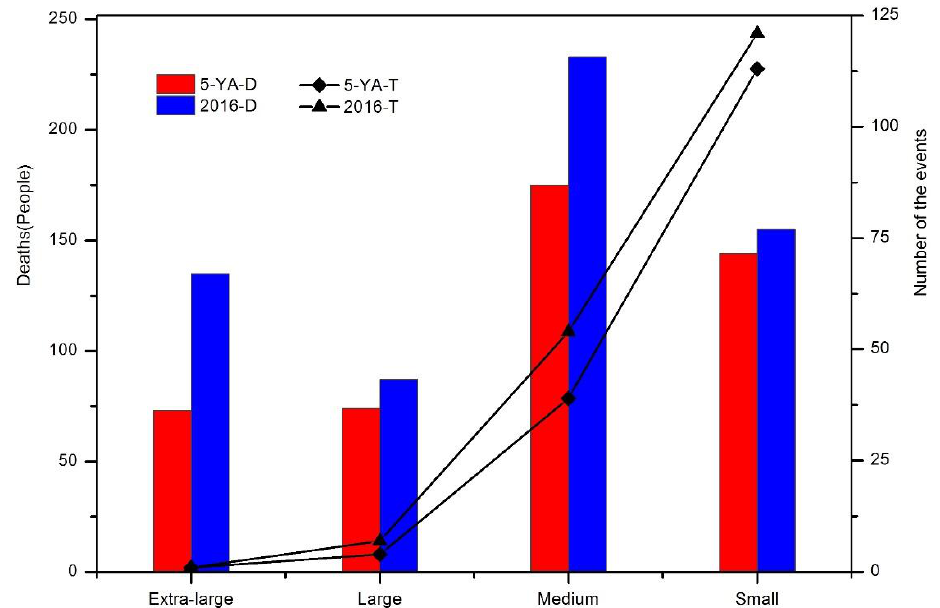
Figure 7. Grade distribution of flash floods in 2011 – 2016. (5-YA-D: the average number of deaths from 2011 to 2015, 5-YA-T: the average number of flash flood events from 2011 to 2015; 2016-D: the number of deaths in 2016, 2016-T: the average number of flash flood events in 2016).